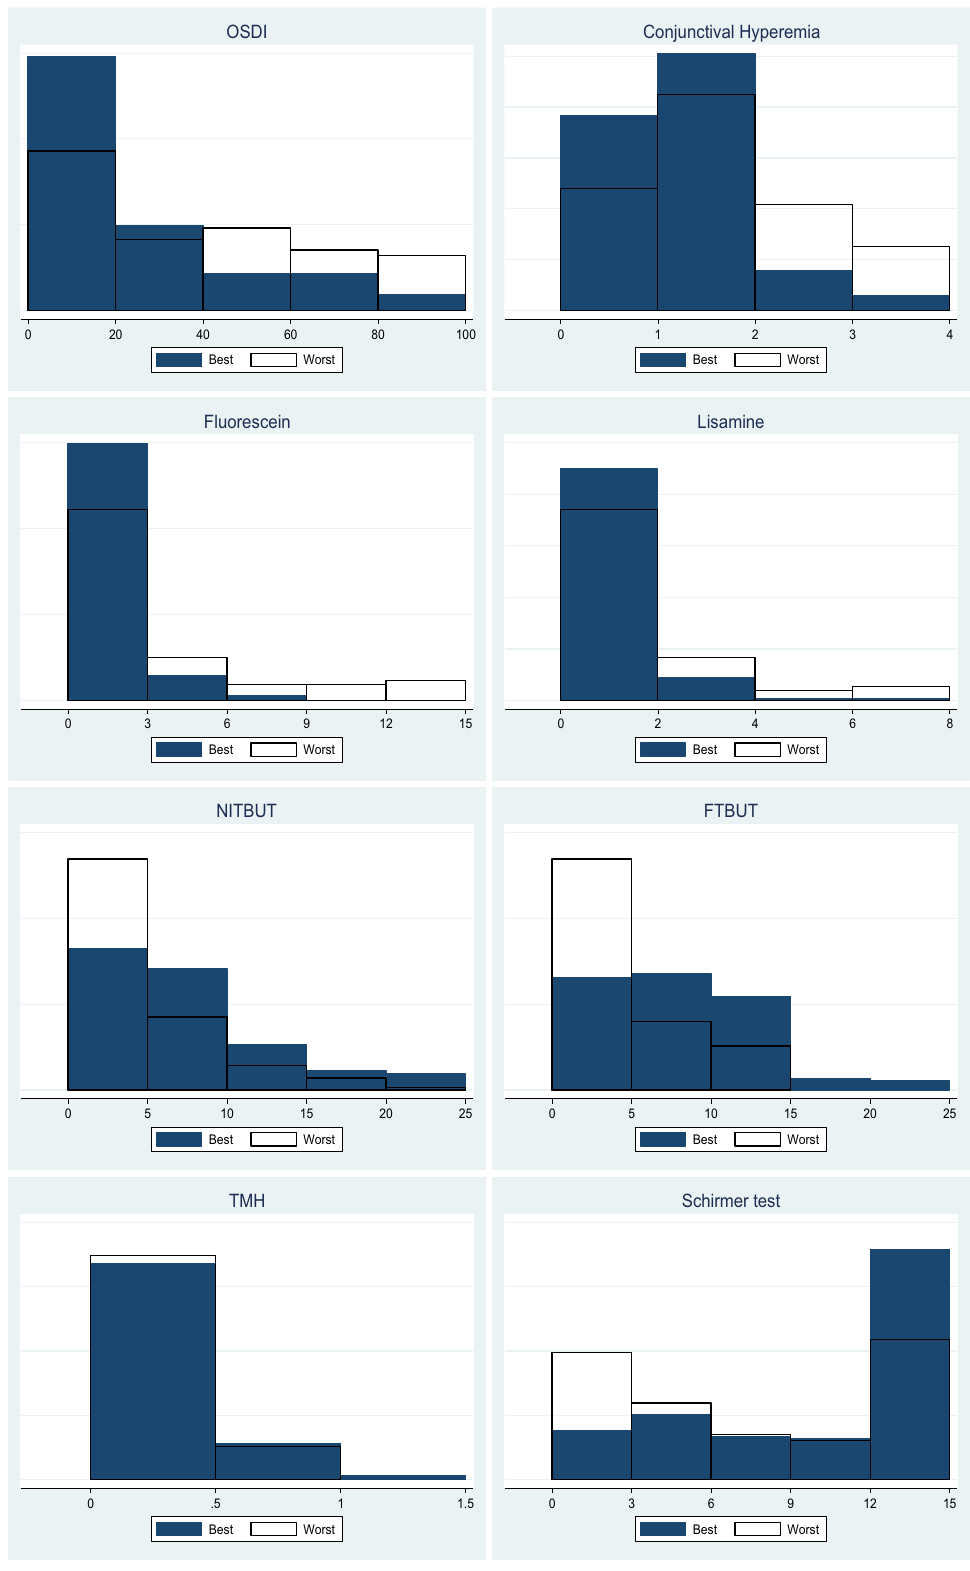
Figure 1. Main ocular surface parameter of patients in it best and worst clinical presentations following hematopoietic stem cell transplantation. OSDI Ocular Surface Disease Index; NITBUT Non-invasive tear break-up time; FTBUT Fluorescein tear break-up time; TMH Tear meniscus height; OD right eye; OS left eye. Of note, OSDI scores more than 40 in all patients at the worst time. TFBUT scores less than 5 in all patients at the worst time. Fluorescein scores more than 5 in most patients at the worst. Lissamine scores more than 4 in most patients at the worst. Schirmer’s test scores less than 5 in all patients at the worst time. According to severity classification, these parameters showed moderate or severe ocular surface dysfunction at the worst time in all patients after